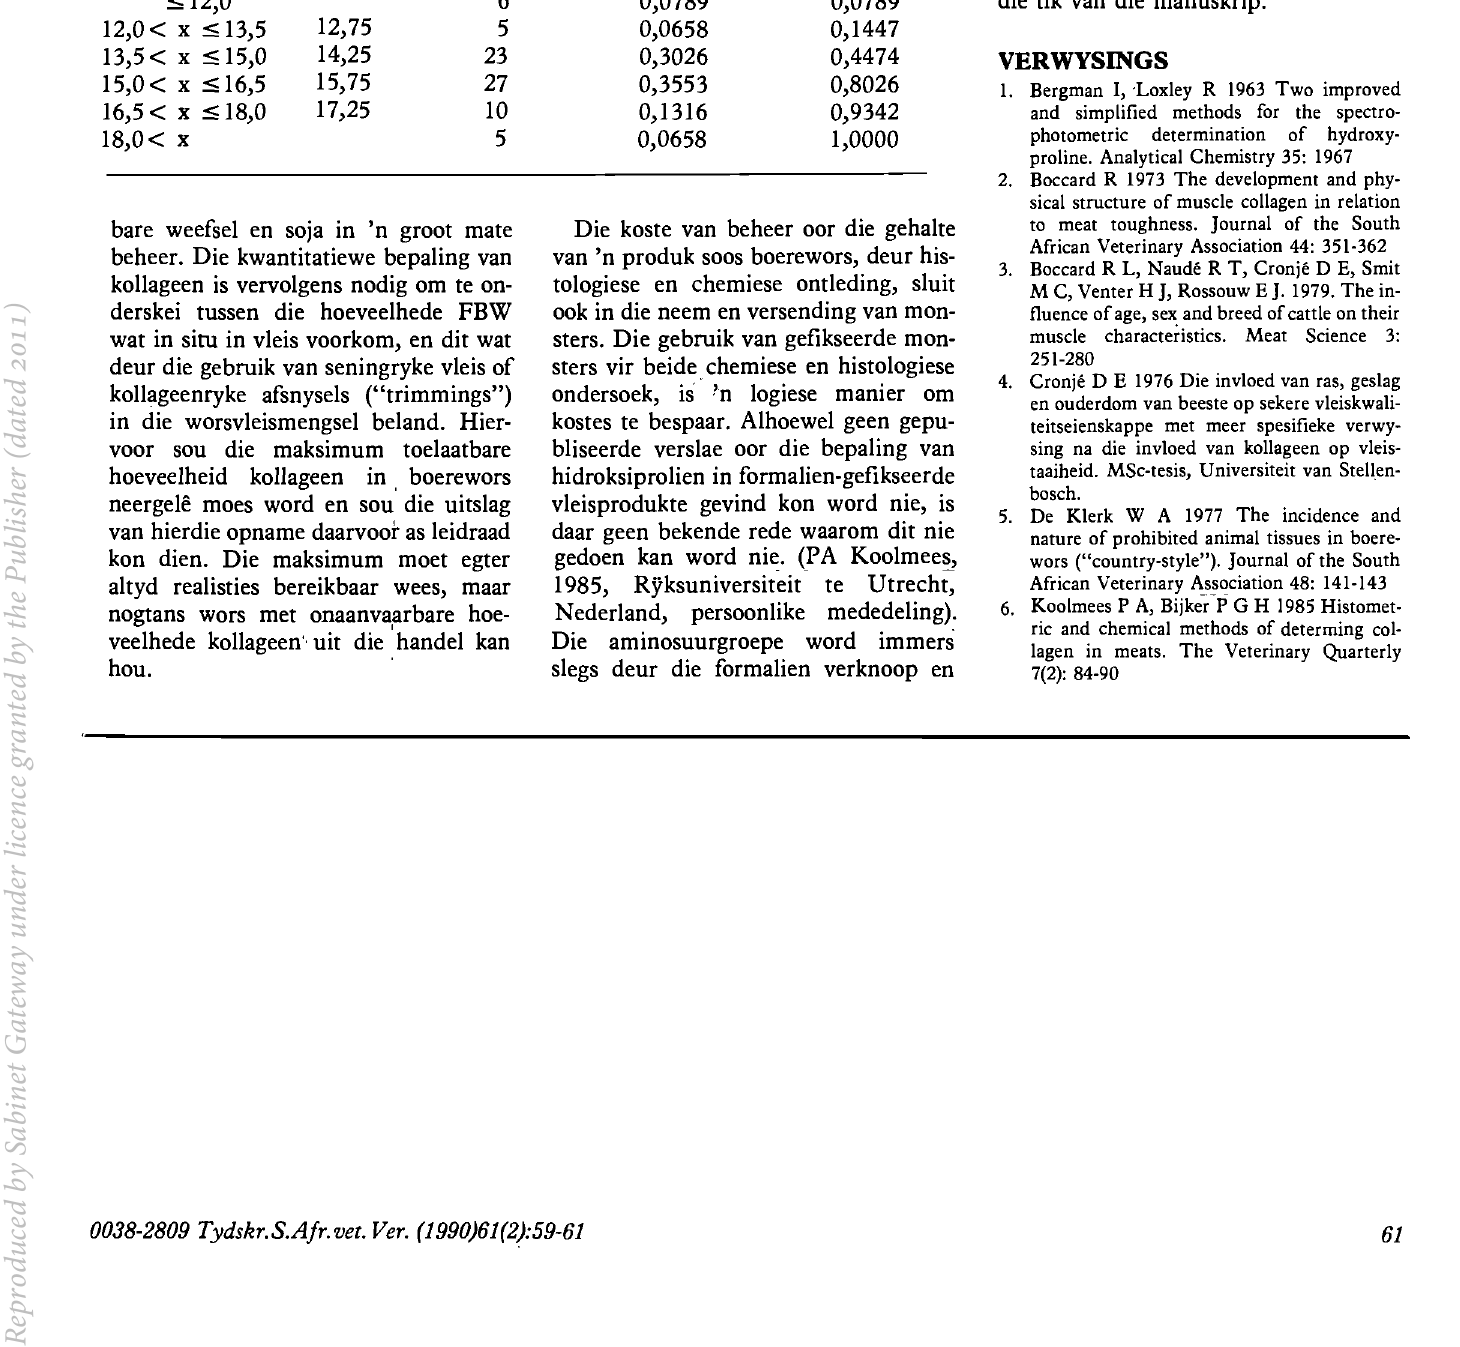
Tabel2: Die persentasie kollageen in 75 gevriesdroogde monsters